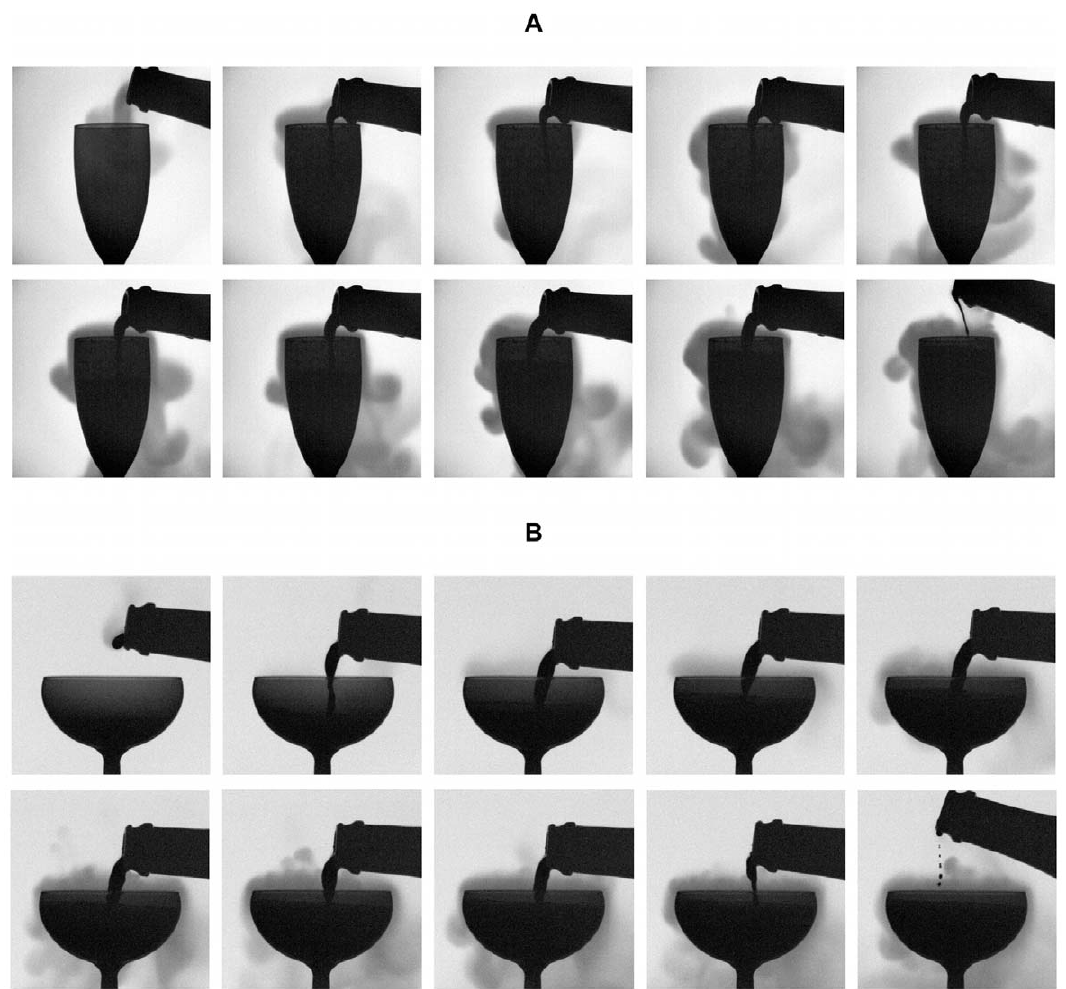
Figure 3. Infrared imaging of gaseous CO 2 desorbing when pouring champagne into both glass types. Gray scale time-sequences illustrating the pouring step as seen through the objective of the IR video camera – for a bottle stored at 20 u C – whether champagne is served into the flute (a) or into the coupe (b).